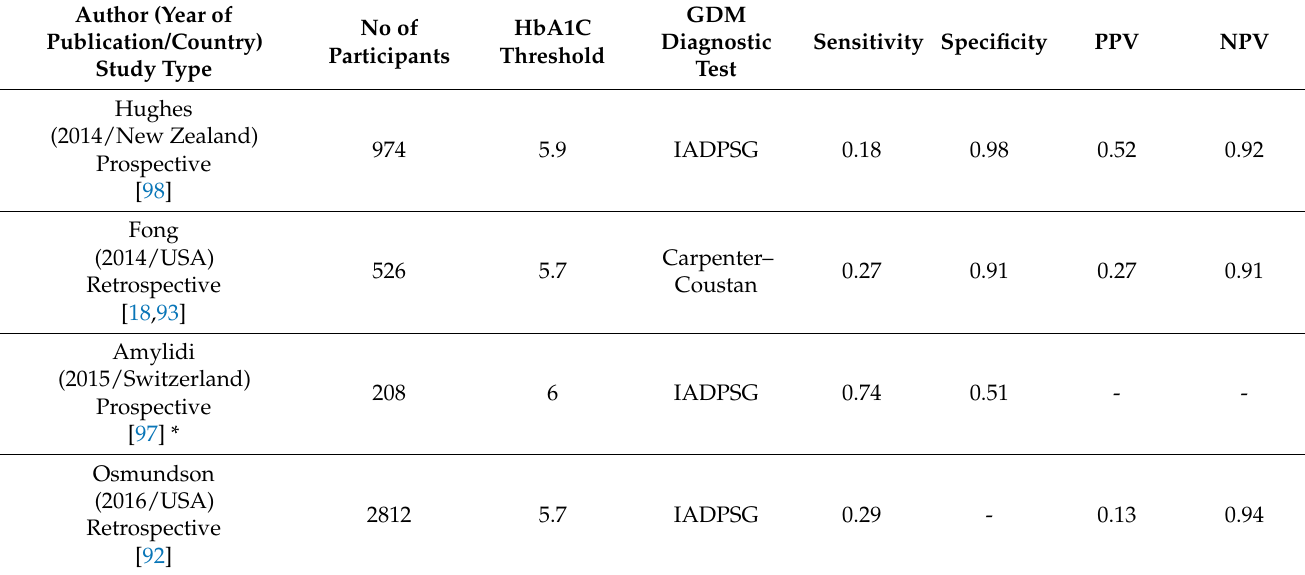
Table 4. Predictive accuracy of HbA1c in early pregnancy to detect subsequent